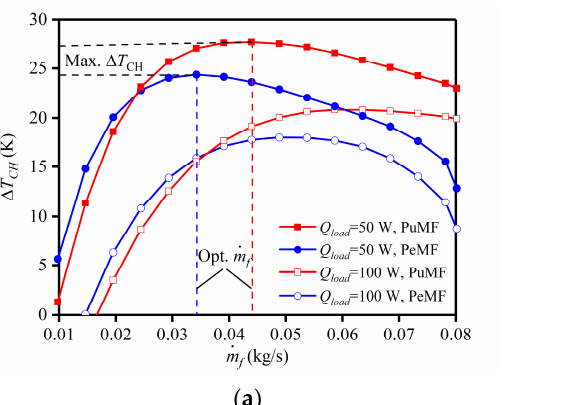
. under different 𝑚(cid:4662) (cid:3033) ( H